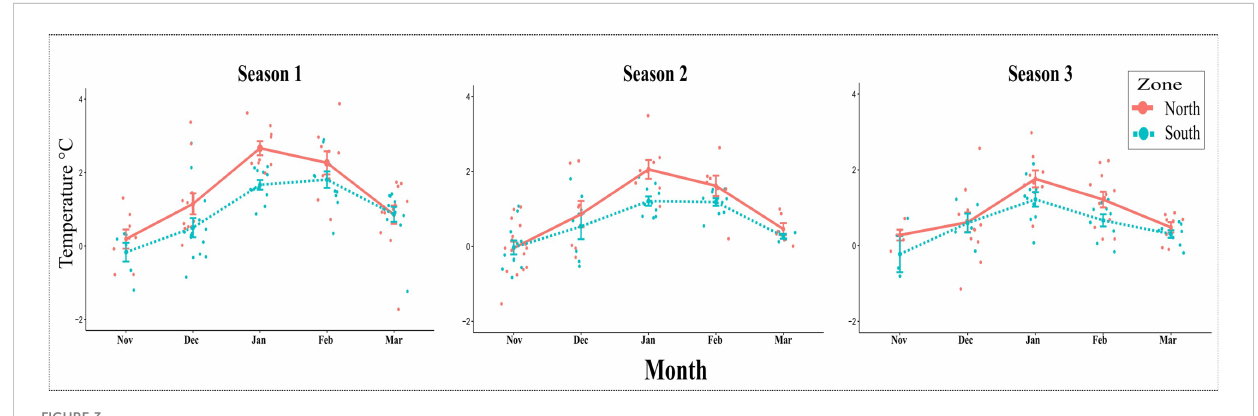
FIGURE 3 Sea surface temperature (SST): average and standard deviation for the three consecutive summers from November to March (northern region in red and southern region in light-blue). Satellite data extracted from two places in northern and southern Gerlache Strait according to squares shown in Figures 1, 2A.